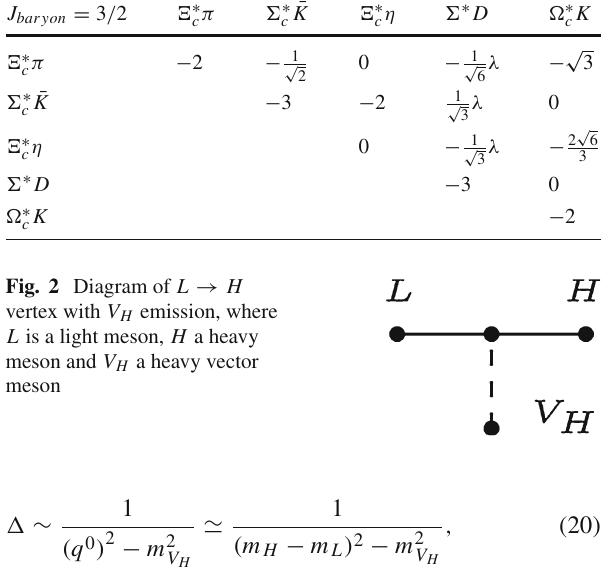
Table 9 D ij coefficients for the PB ∗ states coupling to J P = 3 / 2 − J baryon = 3 / 2